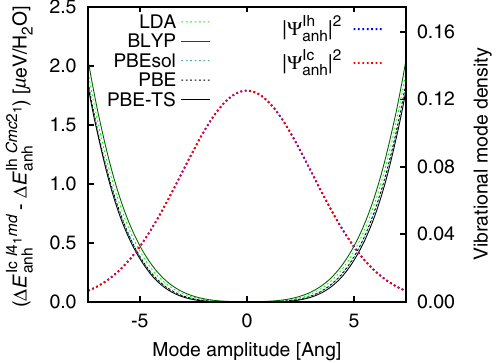
FIG. 3. Difference in the anharmonicity of the BO energy surface Δ E of Ih Cmc 2 1 and Ic I 4 1 md for the LDA [54 – 56], anh BLYP [57,58], PBEsol [59], PBE [47] and PBE-TS [60] func- tionals (thin solid and dotted lines). The dominant contribution to the anharmonicity is quartic. The difference between the results from different functionals is so small it can barely be distin- guished. The different widths of the vibrational densities j Ψ of Ih and Ic (blue and red thick dotted lines, respectively) is indistinguishable on the scale of the figure.